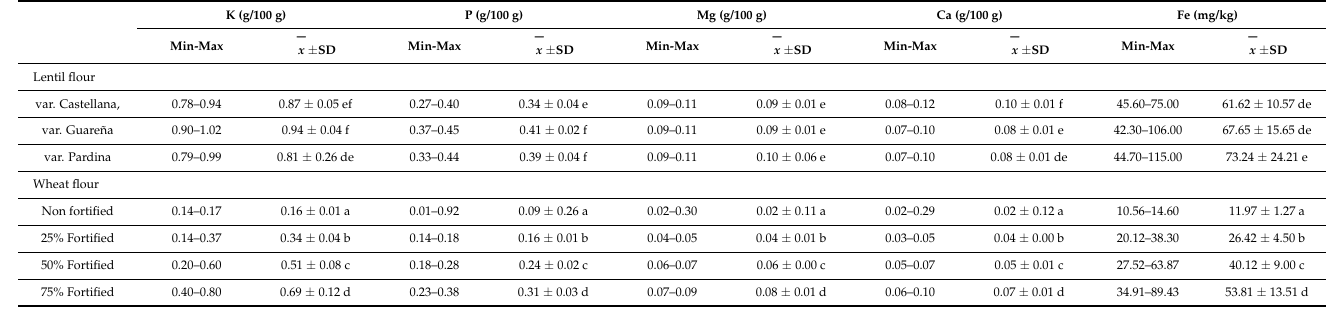
Table 3. Mineral composition of the lentil and wheat flours analyzed; maximum and minimum values, mean value and standard deviation